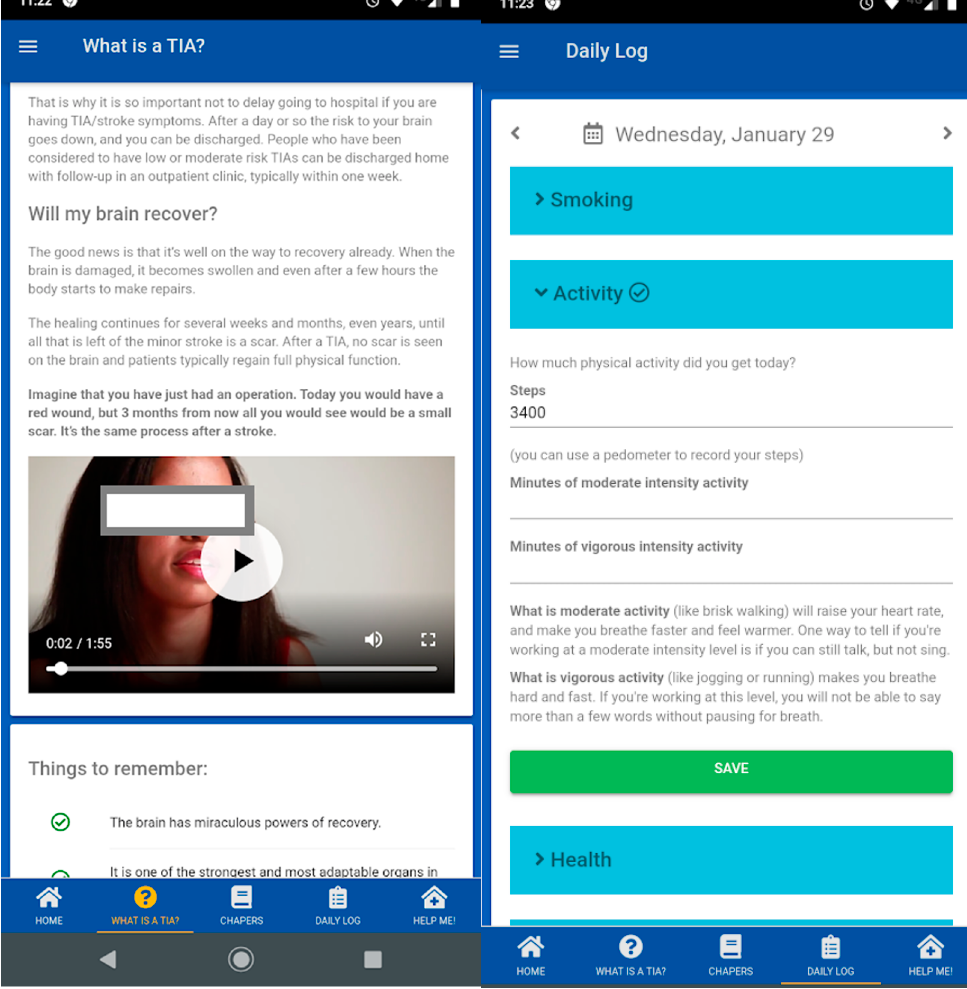
Figure 3. Selected screenshots showing content of the Brain-Fit app.